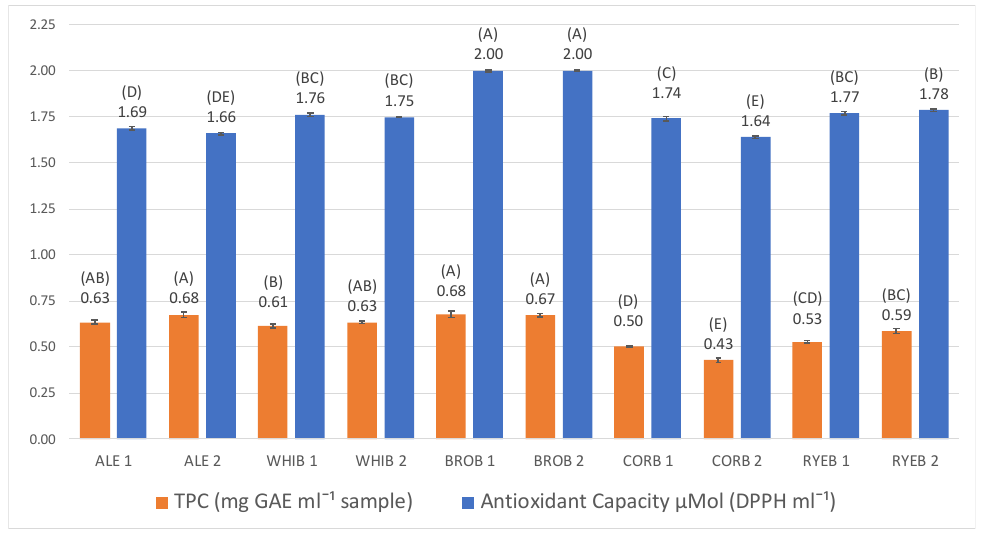
Figure 1. Antioxidant capacity and total polyphenol content in the craft bread beers studied. A–E means without any common letter within the same column are significantly different ( p < 0.05).